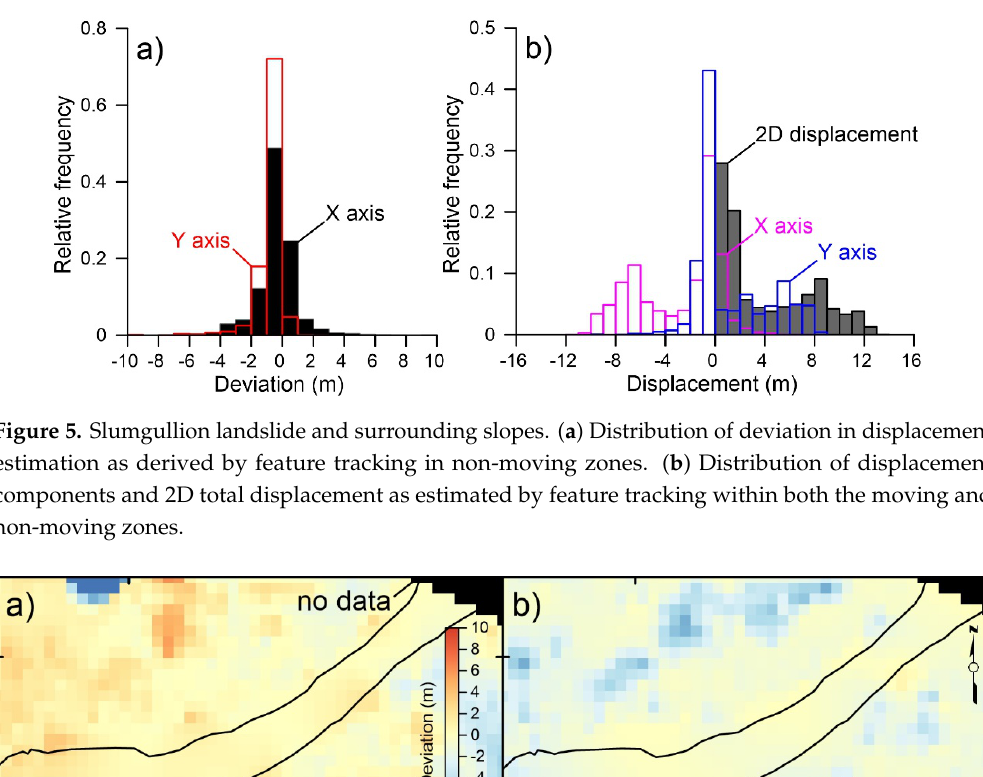
Figure 5. Slumgullion landslide and surrounding slopes. ( a ) Distribution of deviation in displacement estimation as derived by feature tracking in non-moving zones. ( b ) Distribution of displacement components and 2D total displacement as estimated by feature tracking within both the moving and non-moving zones.